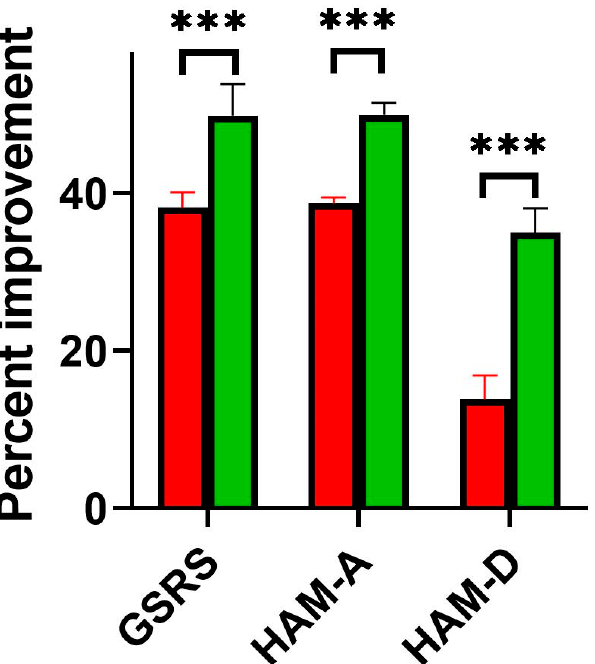
Figure 1. Comparison of nutritional intervention results between the two subgroups of IBS-D patients (Red bars, group IIA without and green bars, IIB with tryptophan limitation intake); GSRS— Gastrointestinal Symptom Rating Scale; HAM-A—Hamilton Anxiety Rating Scale; HAM-D—Hamilton Depression Rating Scale; Percent improvement was calculate. *** p < 0.001. In Group IIA, no signi fi cant changes in the results of urinary excretion of TRP and its metabolites were found, while in Group IIB, 5-HIAA levels, as well as KYN and QA levels, were signi fi cantly reduced, and KYNA levels increased (Table 5). Table 5. Urinary excretion of tryptophan (TRP) and its metabolites: 5-hydroxyindoleacetic acid (5- HIAA), kynurenine (KYN), kynurenic acid (KYNA), and quinolinic acid (QA) in patients with diar- rhea-predominant irritable bowel syndrome without (IIA) and with (IIB) reduction of TRP intake; before (a) and after (b) nutritional intervention; all results expressed in units—mg/gCr; average ± SD. TRP and Its Me- tabolites